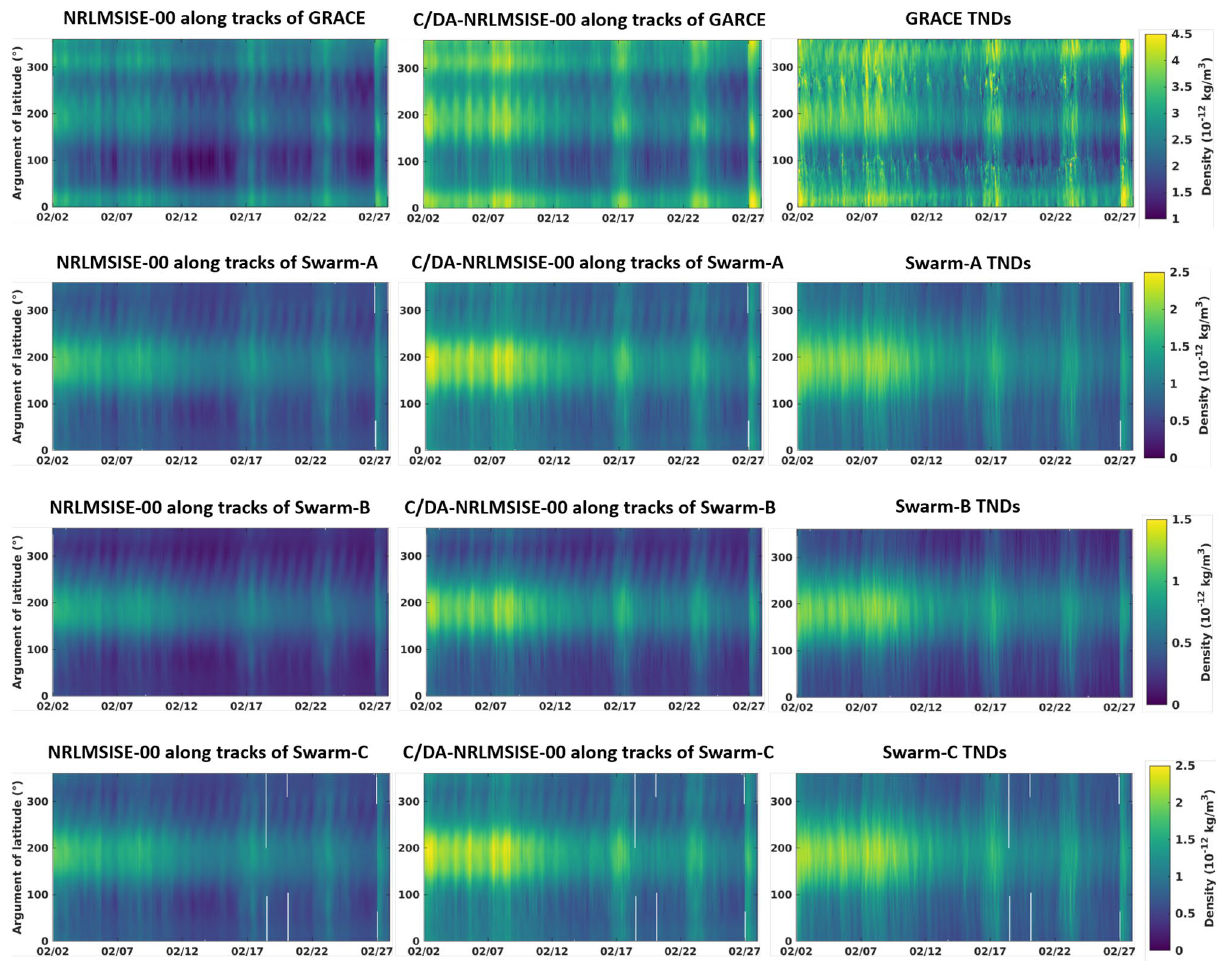
Figure 5. Maps of TND estimates retrieved from NRLMSISE-00 and C/DA-NRLMSISE-00 in the forecasting mode, as well as TND estimates derived along track of GRACE, Swarm-A, -B, and -C. The C/DA-NRLMSISE-00 model is implemented based on the description in the ‘Setup of the C/DA-NRLMSISE-00 Model’ section. The plots were generated using MATLAB (version R2021a, https:// www. mathw orks. com/).